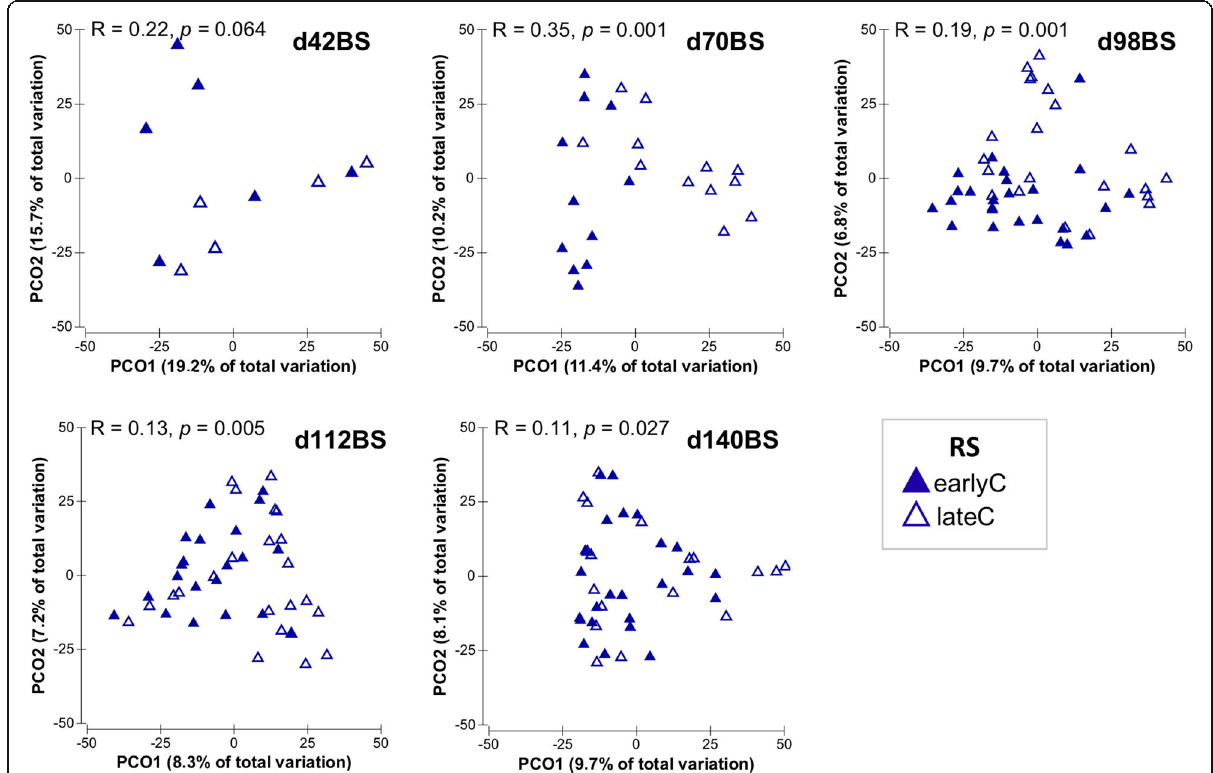
Fig. 3 Principal coordinates analysis plots depicting RS bacterial communities in BS samples of earlyC and lateC groups. Each triangle represents one sample